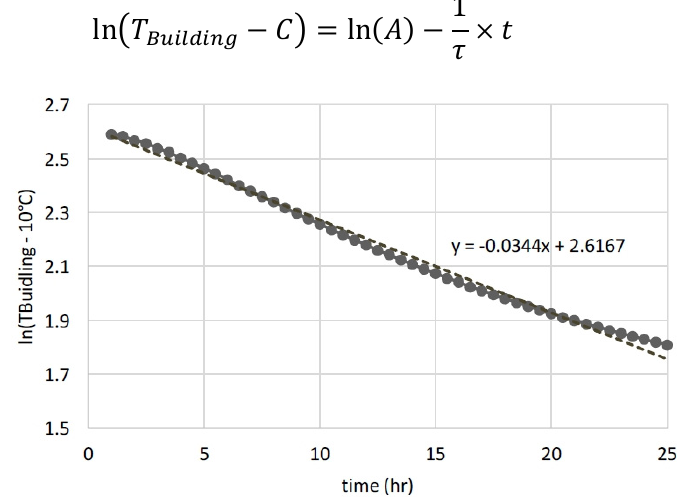
Figure 4. Trendline used to calculate the time constant for the TRNSYS